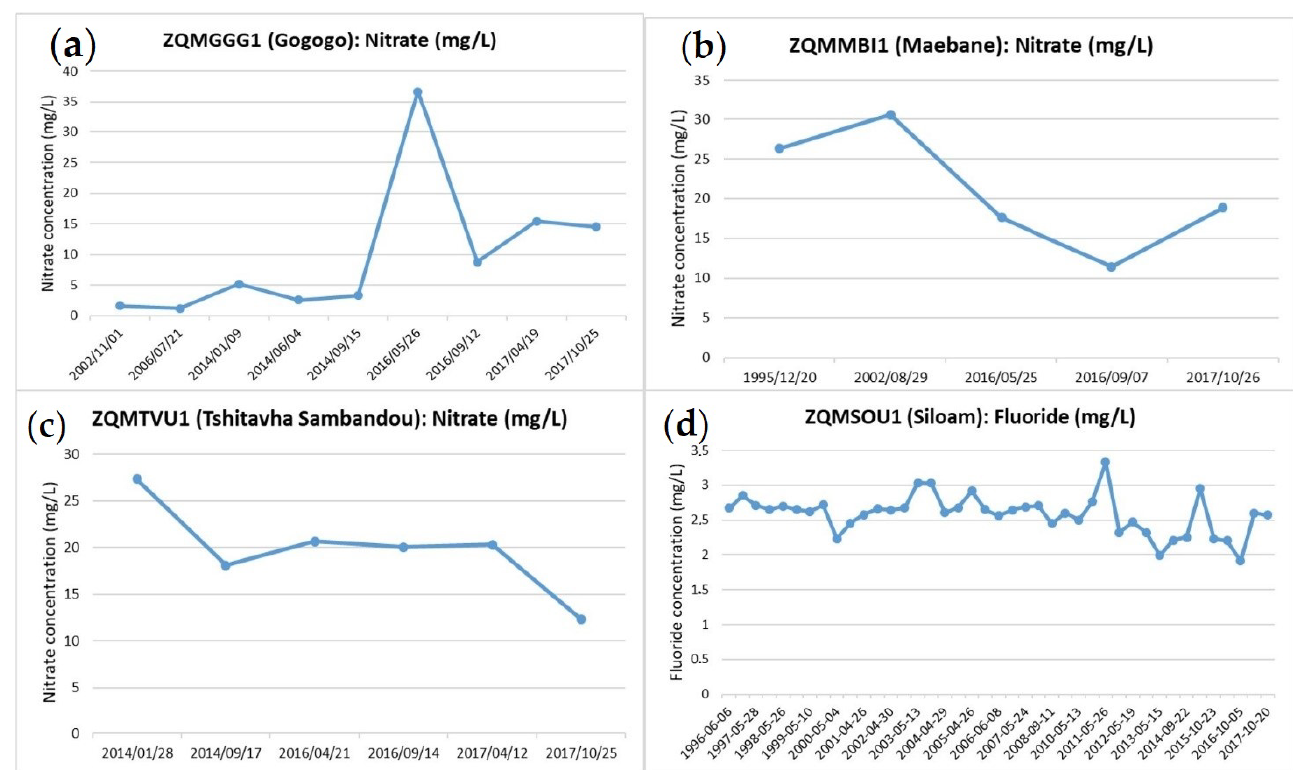
Figure 5. Trend analysis of nitrate and fluoride in the Soutpansberg region (1995–2017), ( a ) Gogogo ( b ) Maebane ( c ) Tshitavha Sambandou ( d ) Siloam.